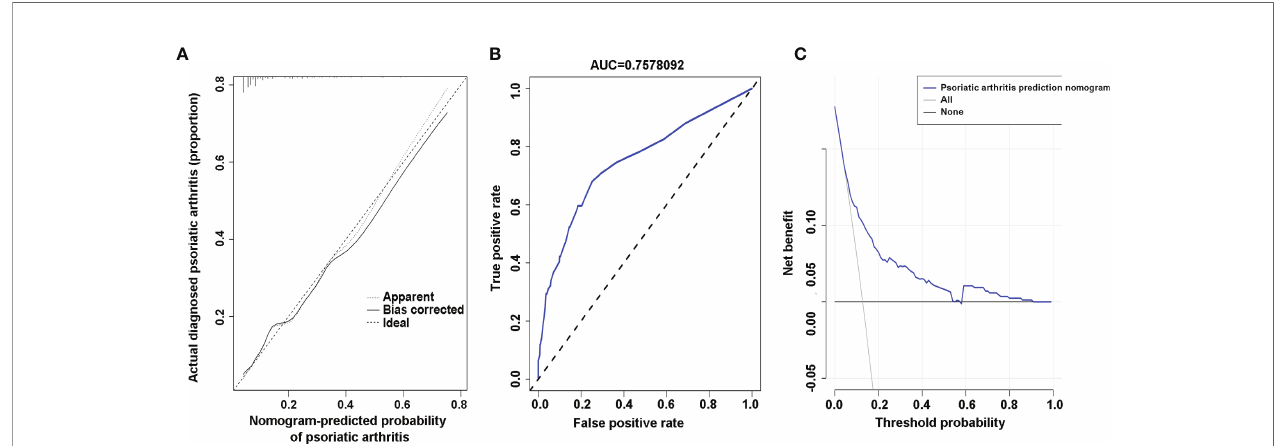
FIGURE 3 | Calibration curves, area under the curve (AUC), and decision curve of the risk of psoriatic arthritis (PsA) predictive nomogram. (A) Calibration curves of the risk of PsA predictive nomogram. The x-axis represents the predicted risk of psoriatic arthritis. The y-axis represents the actual diagnosed psoriatic arthritis. The diagonal dotted line represents a perfect prediction of an ideal model. The solid line indicates the performance of the nomogram, and the more consistent with the dotted line, the better the prediction ability. (B) The AUC of the risk of PsA predictive nomogram. The AUC of the predictive model indicates the probability of accurately predicting whether the patient has psoriatic arthritis in a randomly selected case. The model exhibited good predictive power, and the AUC values of the whole sample (blue) are 0.7578092. (C) Decision curve for the risk of PsA predictive nomogram. The y-axis represents the net bene fi t. The blue line indicates the psoriatic arthritis risk nomogram. The thin solid line represents the assumption that all patients have psoriatic arthritis. The thick solid line represents the assumption that no patients have psoriatic